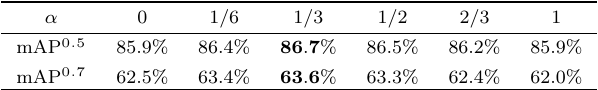
Table 2 Performance of S4Net with different expanded areas. All the results are based on ResNet-50 [57]. α = 1 / 3 gives the best